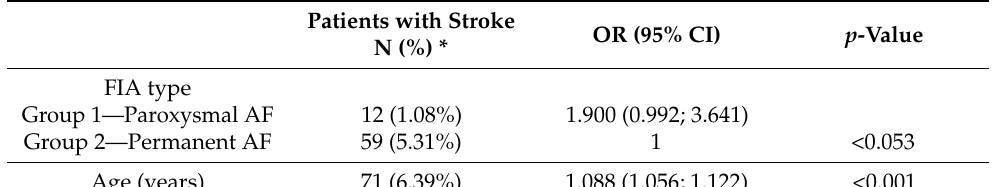
Table 8. Multiple logistic regression analysis for risk of dementia after AF diagnosis for AF type and age, AF—atrial fibrillation, N—number of patients, OR—odds ratio, 95% CI—95% confidence interval, *—percentage based on the total number of patients (1111 patients).